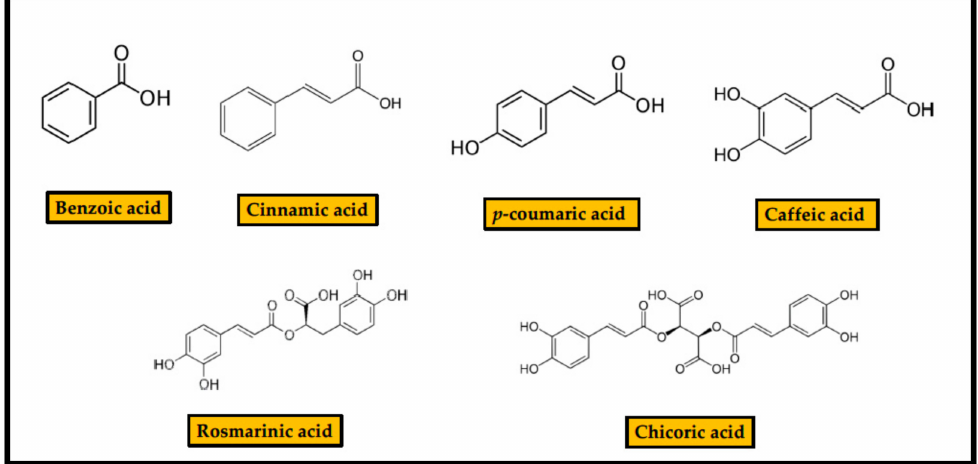
Figure 2. Structure of phenolic